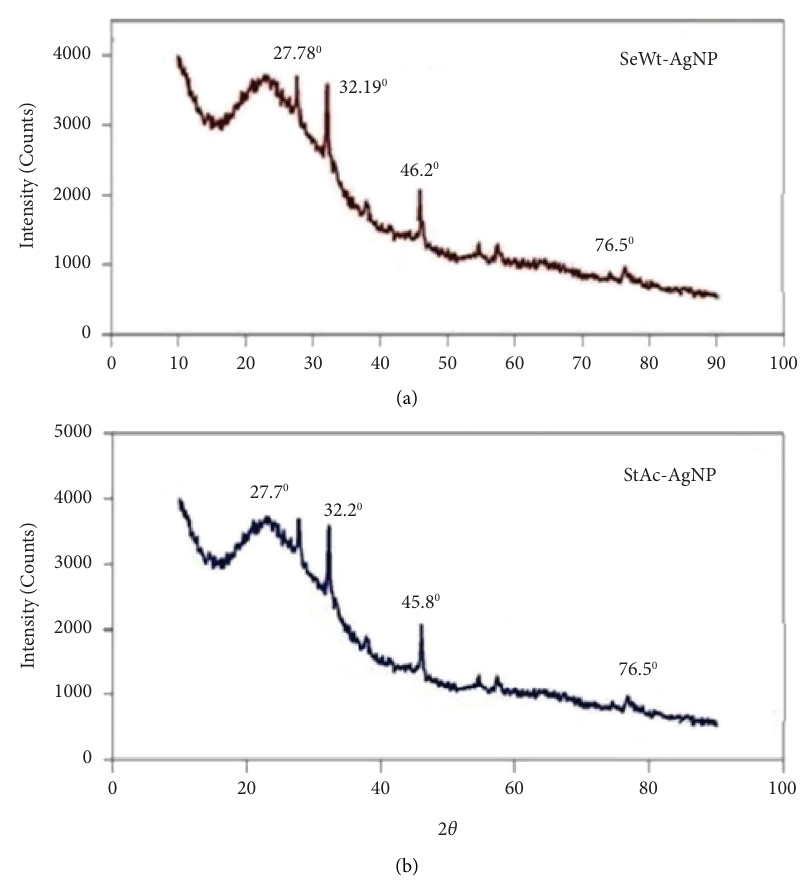
Figure 3: XRD peaks for (a) AgNPs synthesized from seed extracts of W. tinctoria and (b) AgNPs synthesized from stem extracts of A. catechu